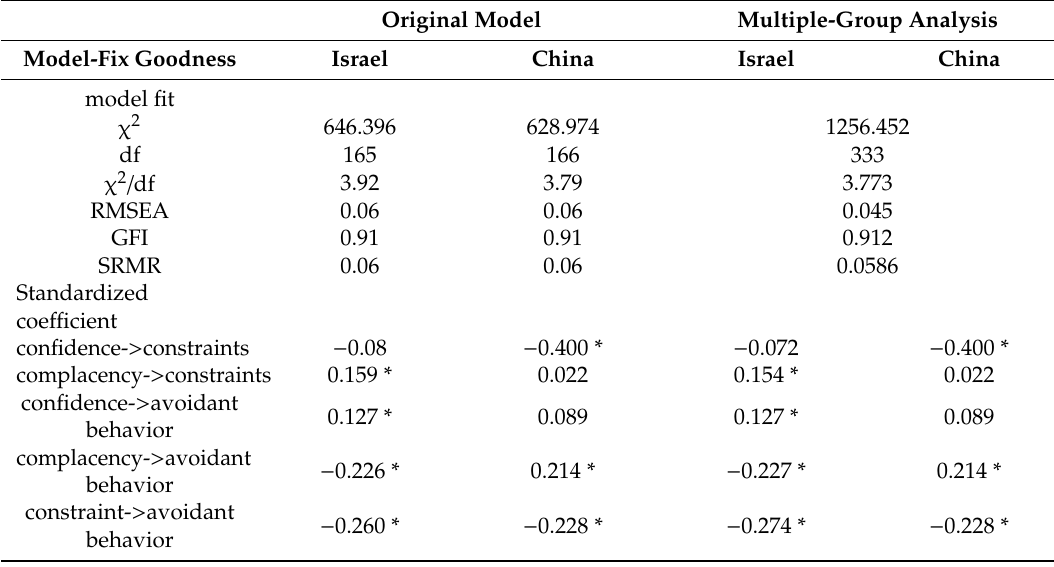
Table 6. 3C-avoidant behavior model.